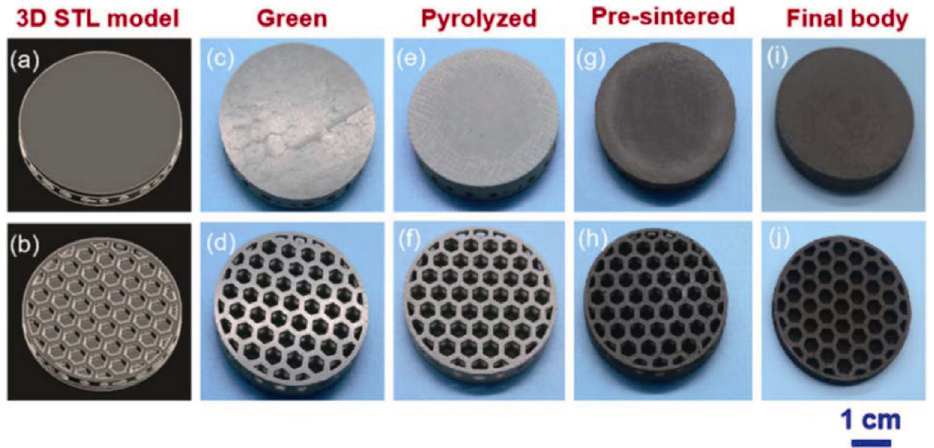
Fig. 32 Lightweight SiC ceramic optical mirror by DLP and PIP. Reproduced with permission from Ref. [87], © Elsevier Ltd and Techna Group S.r.l.